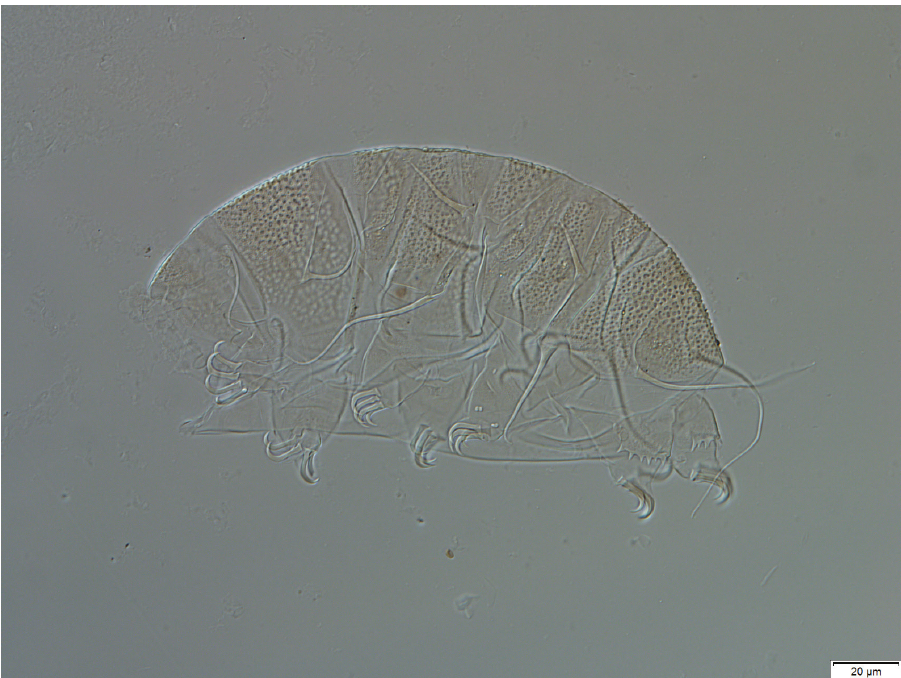
Figure 1. Echiniscus quadrispinosus quadrispinosus Richters, 1902,